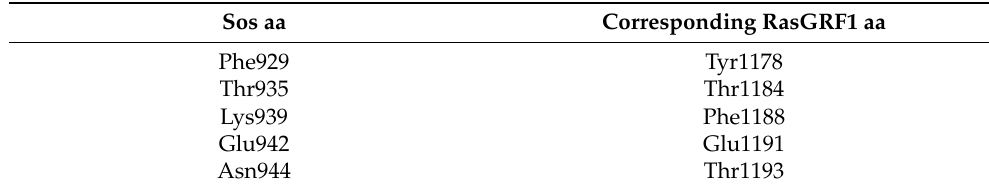
Figure 4. FASTA sequence alignment between the Sos and RasGRF1 regions able to bind the Ras protein. RasGRF1 amino acids corresponding to Sos hot spots are reported in Table 2. As can be seen, the pairs Thr935-Thr1184 and Glu942-Glu1191 shared the same amino acid, while Phe929 (Sos) and Tyr1178 (RasGRF1) both presented hydrophobic side chains, and Asn944 (Sos) and Thr1193 (RasGRF1) shared polar uncharged side chains. Only Lys939 and Phe1188 were very different amino acids, whereas lysine showed an electrically charged side chain, while phenylalanine exhibited a hydrophobic side chain. The amino acids of RasGRF1 highlighted in the above-described comparison were considered for the next steps of the analysis. Table 2. Correspondences of Sos hot-spot residues (from biological assays [61] and computational alanine scanning) to RasGRF1 amino acids identified by performing protein structures